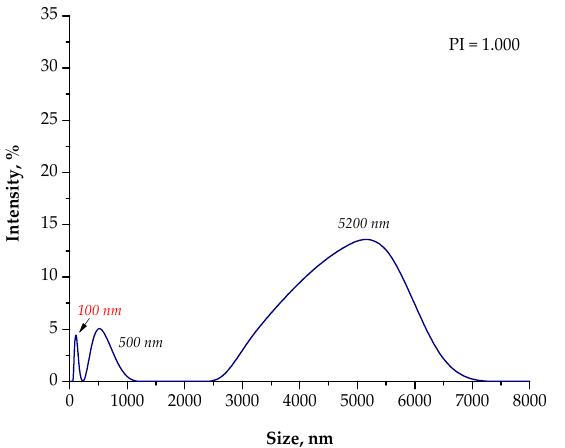
Figure 10. The size analysis of the Fe 3 O 4 @Ag particles obtained as a result of the synthesis performed using the 3% Arabic gum solution and the oil ( O ) reaction environment after 15 min of sonication.